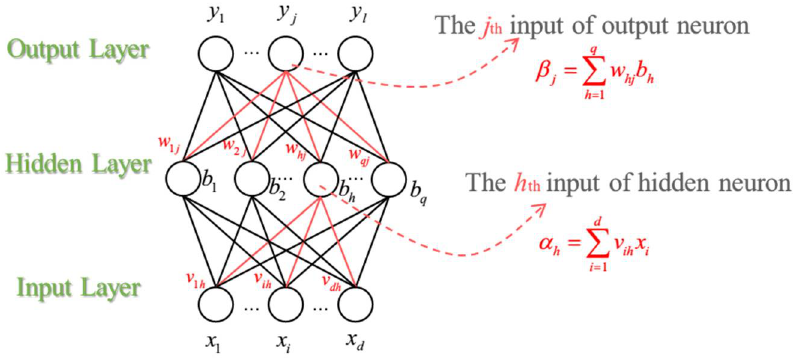
Figure 4. The illustration of surrogate model design. The output value can be calculated by com- mercial software automatically.